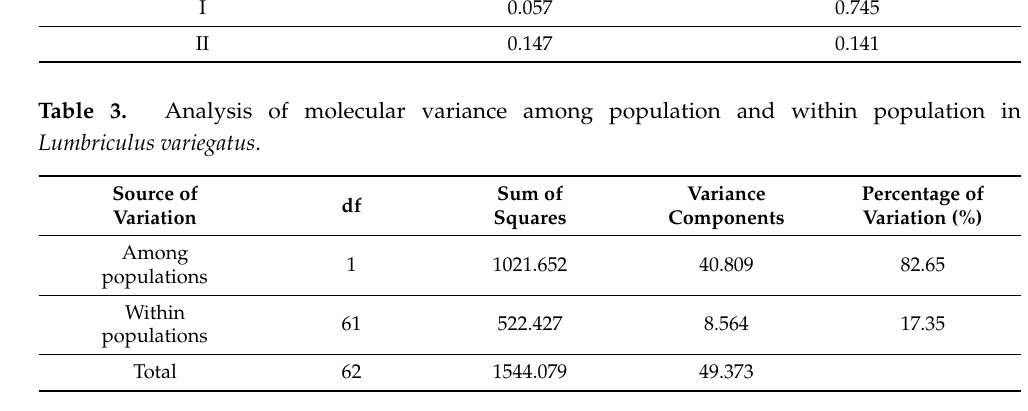
Table 2. Genetic distances within lineages (on diagonal), genetic distances among lineages (below diagonal) and lineages pairwise F st (above diagonal) based on combined COI and 16S gene sequences. Lineage